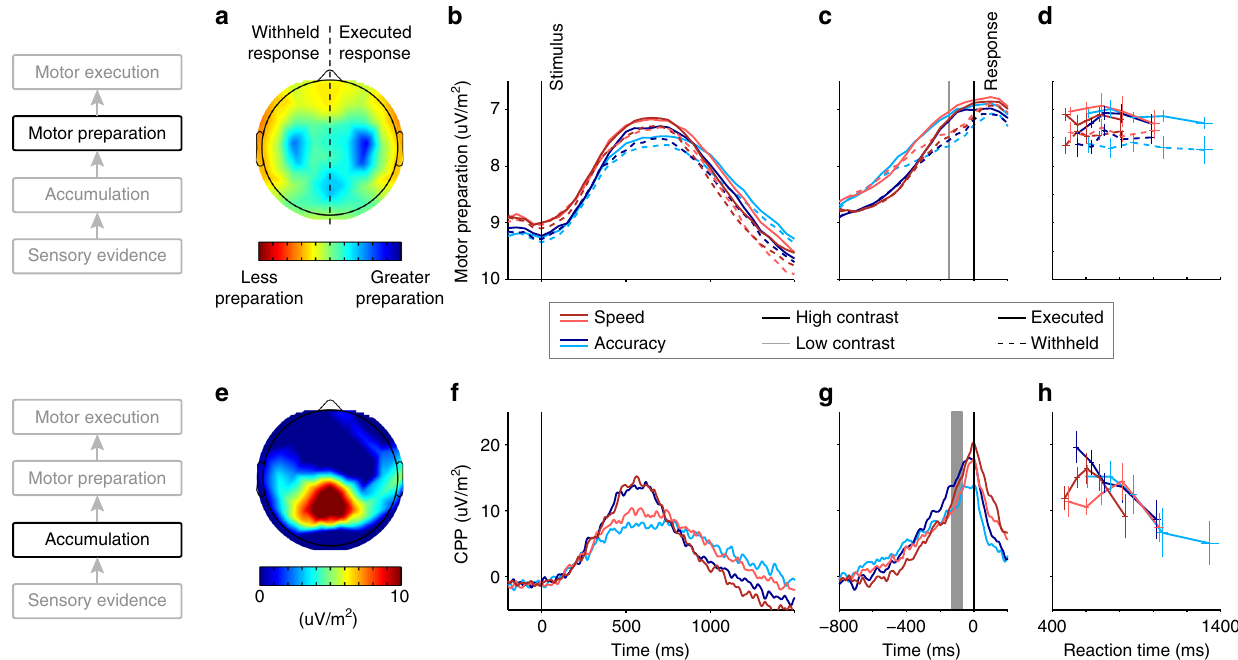
Fig. 4 Evidence and urgency effects on effector-selective and motor-independent decision signals. a – d Motor preparation. a Topography of the decrease in Mu/Beta-band amplitude at response, relative to pre-evidence baseline. Topography for left-hand responses is collapsed with a left-right-reversed topography for right-hand responses. b Stimulus-locked and c response-locked timecourses of Mu/Beta activity re fl ecting temporally increasing motor preparation (reduced spectral amplitude; note reversed y-axis) for the executed (solid) and the withheld (dashed) response. Spectral amplitudes for each time point are computed in a 300 ms window centered on that time point, resulting in a temporal smoothing effect. The gray vertical line indicates the time point for measurement of pre-response motor preparation (center of 300-ms time window). d Pre-response motor preparation at response plotted over RT. The level reached by the motor preparation towards the executed response (solid) is independent of evidence strength (light vs. dark), Speed/ Accuracy regime (red vs. blue), and RT. As expected, motor preparation for the withheld response alternative reached signi fi cantly lower levels than that